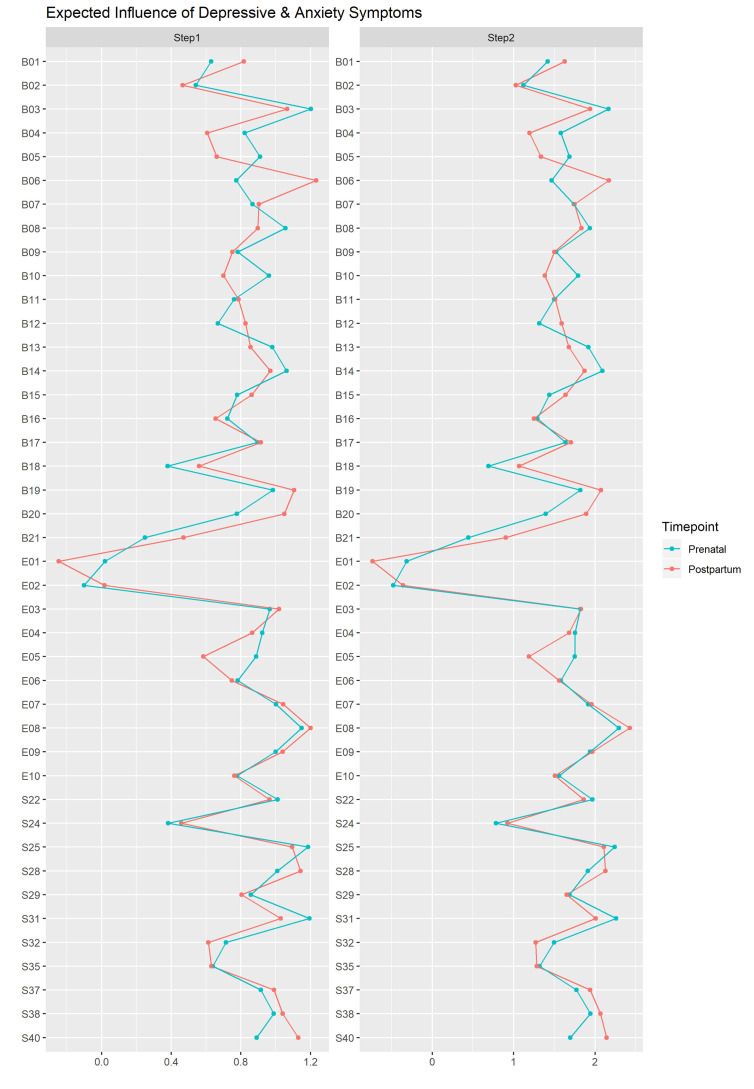
Z scores of the one-step and two-step expected indices of depressive and anxiety symptoms in the prenatal and post-partum networks. See Figure 1 for the wordings of the symptoms.